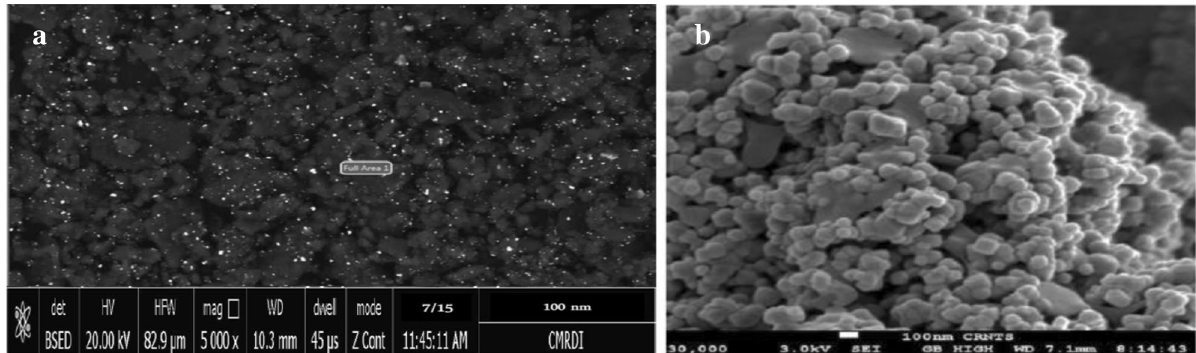
Figure 2. Sample SEM-based morphology images: ( a ) DSPN, and ( b ) TiO 2